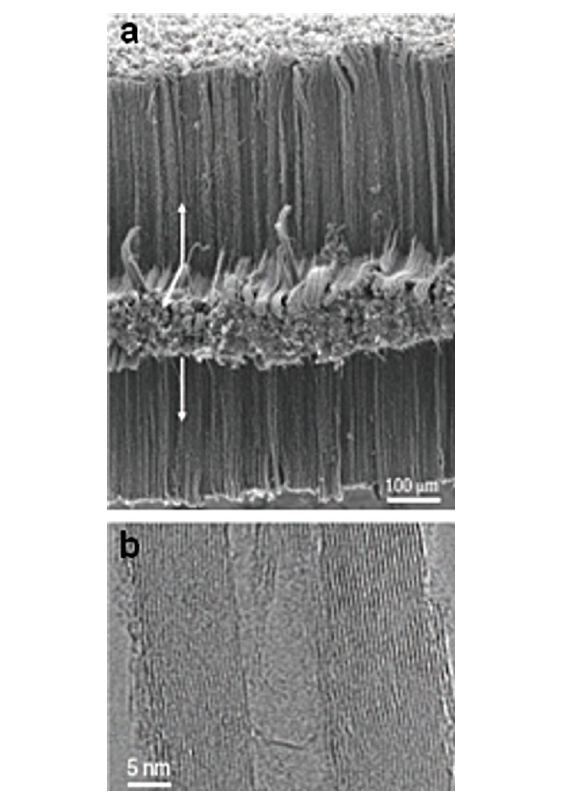
Figure 2: (a) SEM and HR-TEM images of aligned MWCNTs grown in three dimensions on Inconel substrates by floating catalyst CVD. The directions of CNT growth are indicated by arrows. (b) High-resolution transmission electron microscopy image of a typical nanotube grown